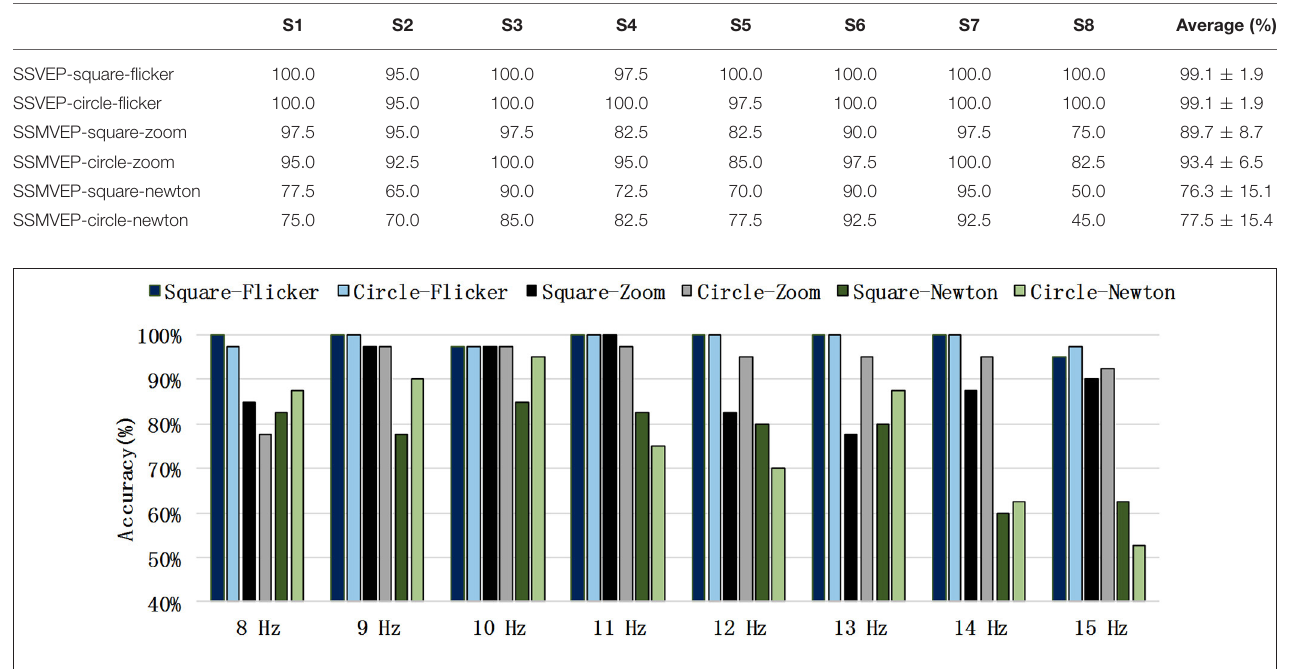
FIGURE 5 | Recognition accuracy in each stimulus